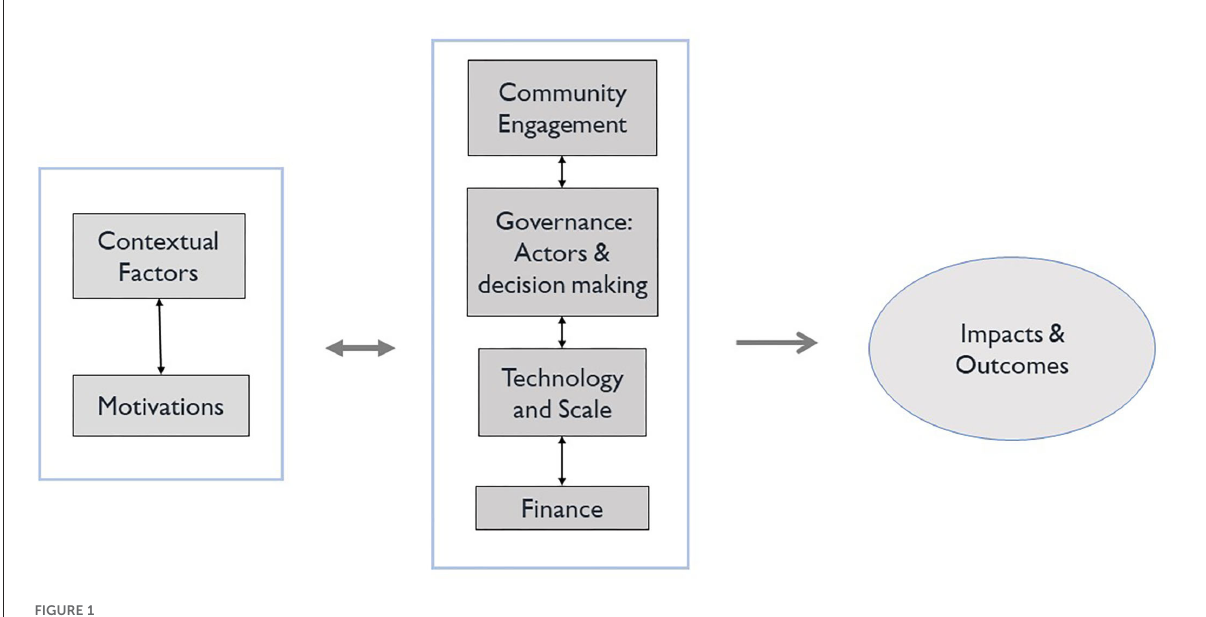
FIGURE1 Framework developed by Hicks and Ison